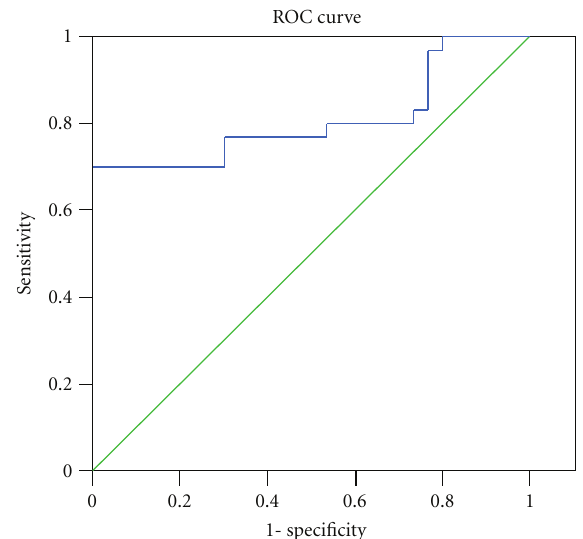
Figure 4: Receiver operating characteristic (ROC) curve of ENA6 Sm for di ff erentiation between SLE patients and healthy control.